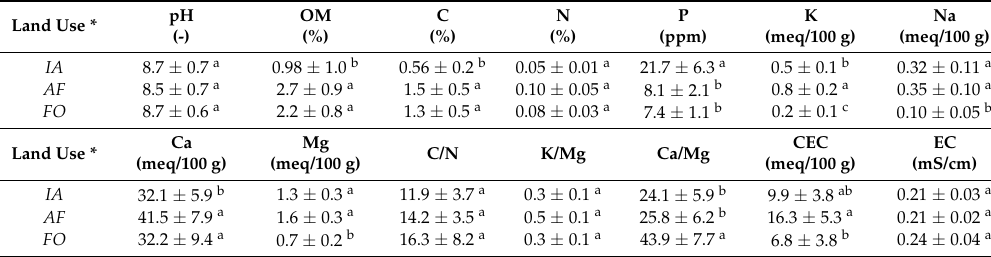
Table 2. Soil chemical characteristics (mean ± standard deviation) in the study area (Villamalea, Castilla La Mancha, SE Spain). Different lower-case letters indicate statistically significant differences following the LSD test ( P -value <